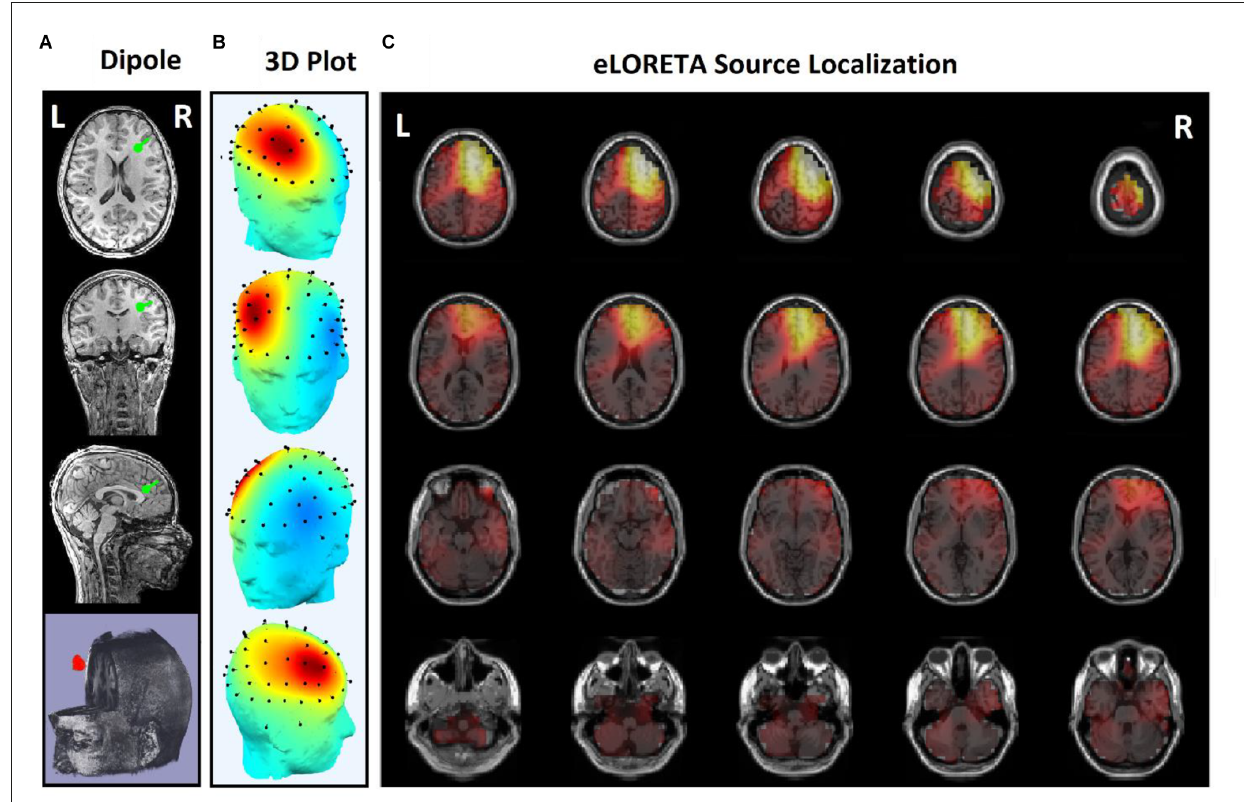
FIGURE7 Source localization of the rTMS stimulation foci in right prefrontal cortex (R-DLPFC) for a responder subject. (A) Dipole coordinates of the identified focus in right side on a default MRI. (B) Position of the foci identified by ICA on the surface of the skull. (C) Source localization in right DLPFC by